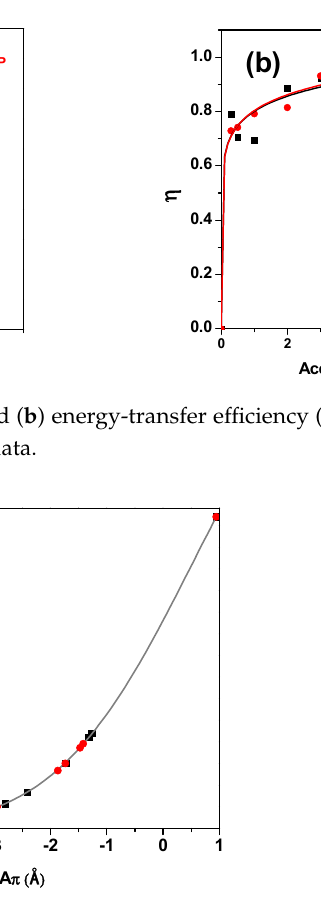
Figure 14. Fluorescence quantum yield ( Φ DA ) versus the conjugated length (A π ). Solid curves refer to the fitting